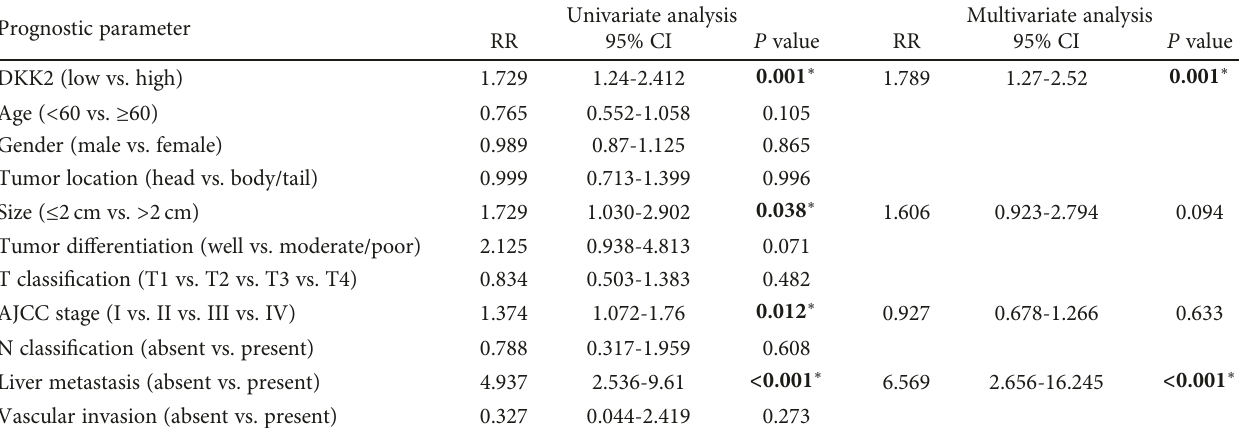
Table 2: Univariate and multivariate analyses of prognostic parameters for survival in PDAC patients. Prognostic